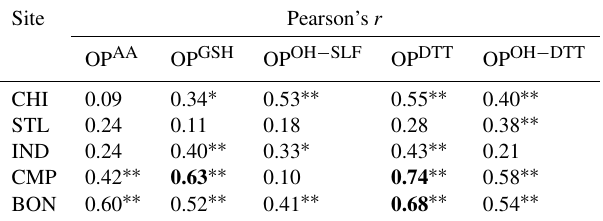
Table 3. Pearson’s correlation coefficient ( r ) between water-soluble and methanol-soluble OPv for different endpoints at five sampling sites. Correlations with r > 0 . 60 are shown in bold. Single asterisks ∗ and double asterisks ∗∗ indicate significant ( P < 0 . 05) and highly significant ( P < 0 . 01) correlations,